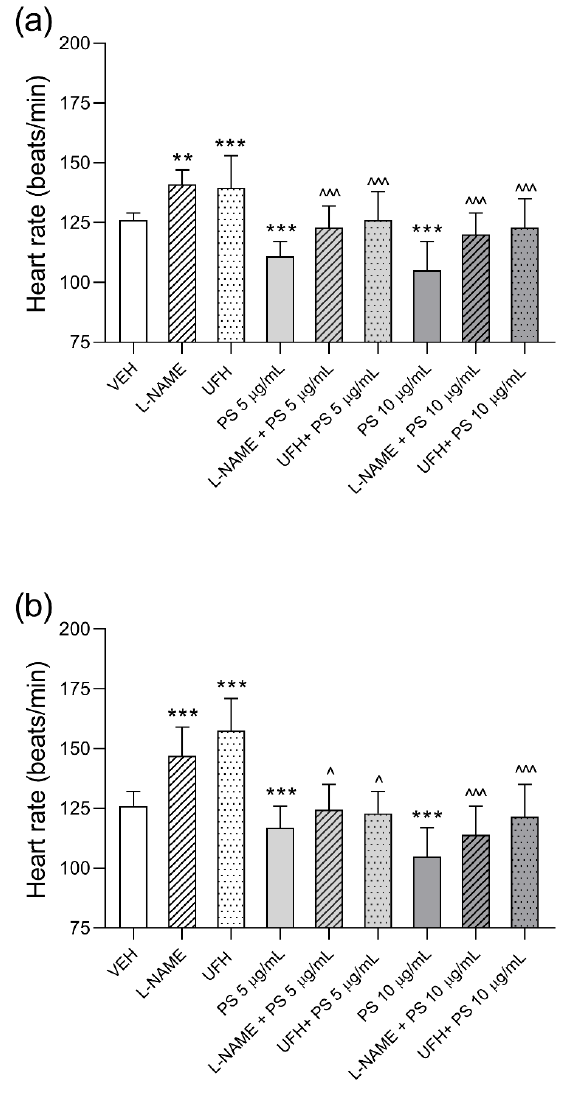
Figure 5. Heart rate values of zebrafish embryos at 24 h post–fertilization exposed for 24 ( a ) and 48 h ( b ) to vehicle (VEH), L –NAME (0.5 mM), unfractionated heparin (UFH, 0.5 U/mL), protamine sulfate (PS), PS together with L –NAME (0.5 mM), or PS together with UFH (0.5 U/mL). Data are shown as medians with ranges. Note: ** p < 0.01, *** p < 0.001 vs. VEH, ^ p < 0.05 ^^^ p < 0.001 vs. PS at the appropriate concentration, Kruskal–Wallis ANOVA with Dunn’s post–hoc test, n = 30 for each concentration.